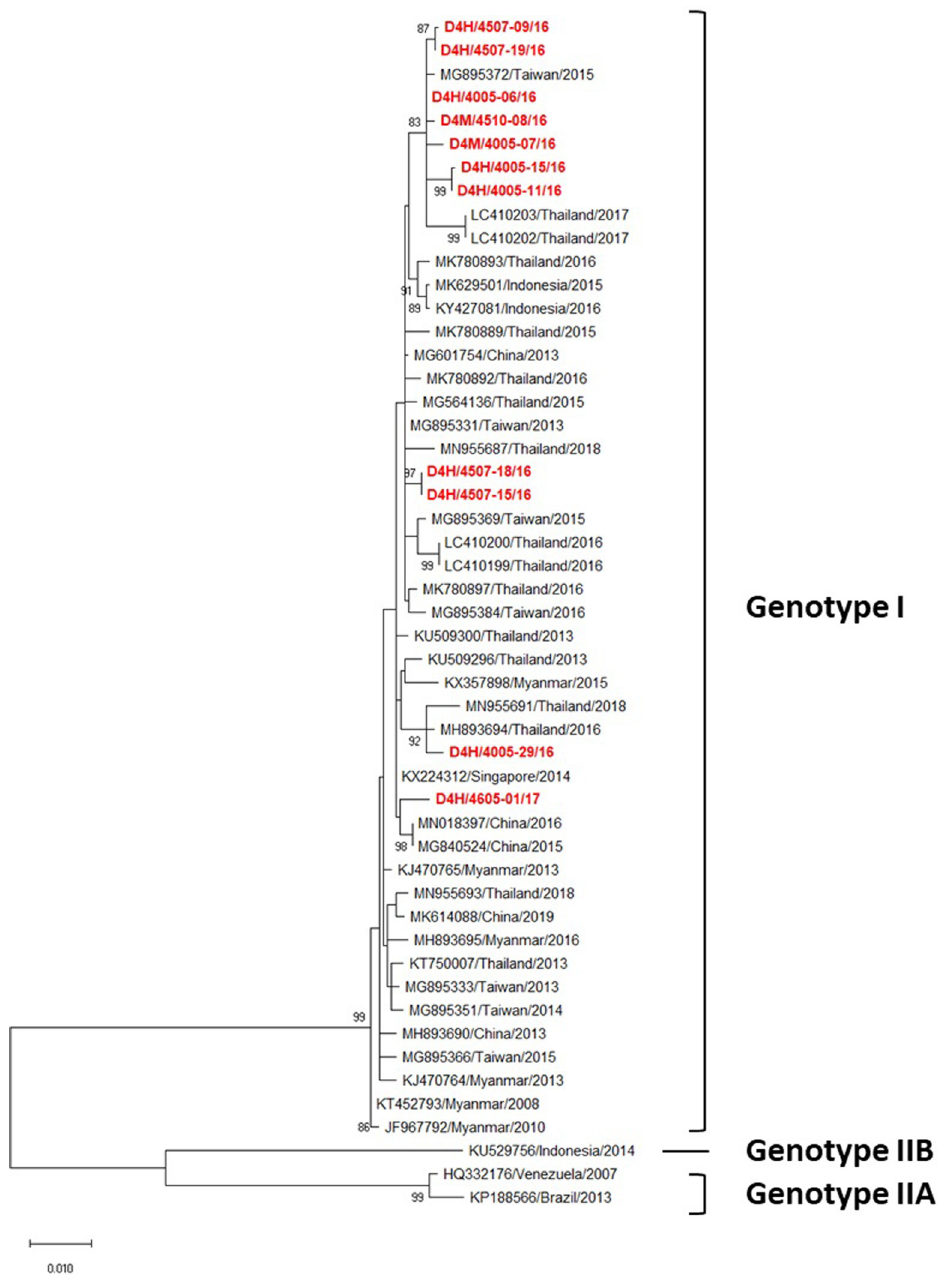
Fig 5. Phylogenetic analysis of DENV-4. Maximum-likelihood tree of the E gene sequences of DENV-4 was generated in the MEGA X program using the TN93 + G model with 1000 bootstrap replications. Bootstrap support values exceeding 80% are shown on branch nodes. The virus names of each sequence retrieved from the NCBI database are labeled as follows: GenBank accession number/country/isolated year. Samples collected in the present study are in red bold font. Annotation on the right denotes DENV